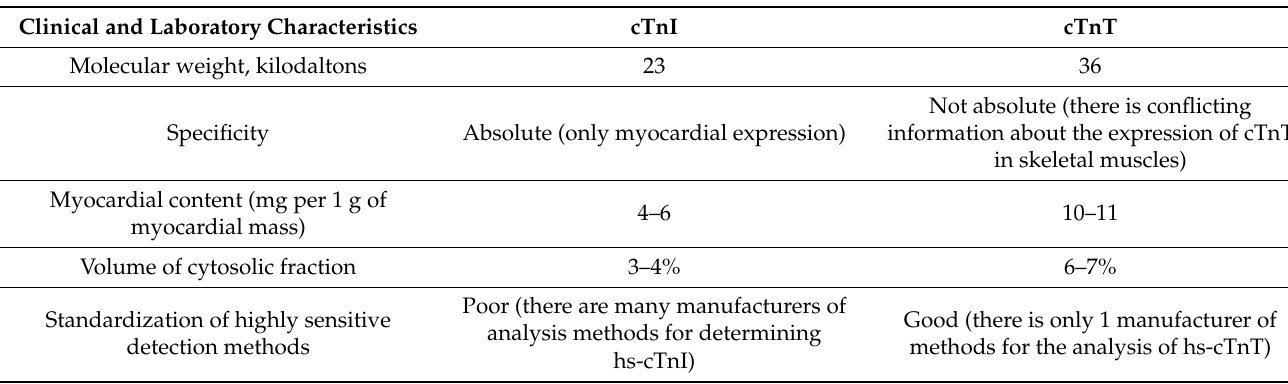
Table 3. Comparative biochemical characteristics of